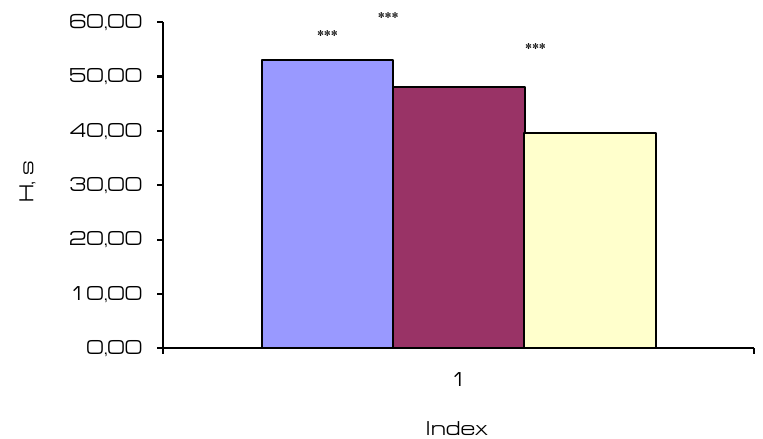
Fig.2. Indicators of test “high jump” of elite sportsmen, who specialize in speed rock-climbing (n=10), complex rock- climbing (n=10) and mountaineering (n=6): H, s – height of jump, cm *** - differences are confident at р<0.001;